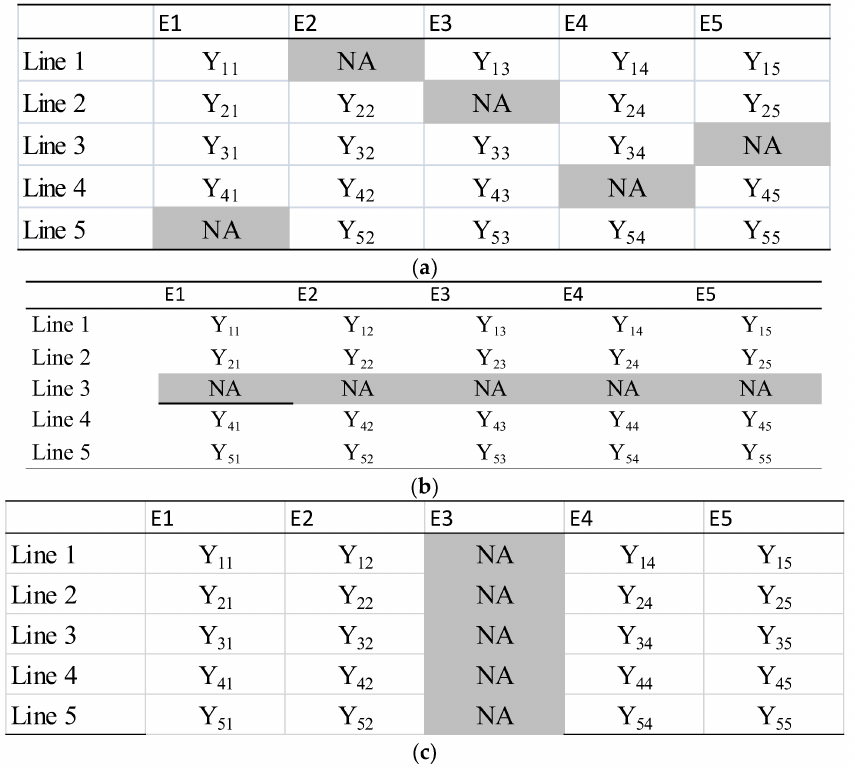
Figure 2. Graphic representation of the Cross-Validation schemes: ( a ) CV2, incomplete field trials; ( b ) CV1, prediction of newly developed lines; and ( c ) CV0, predicting crop performance in new environments. NA, stands for a not available record (missing